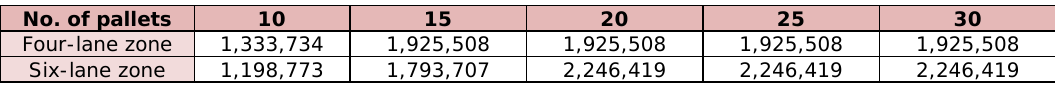
Table 5. “Annual throughput against different numbers of pallets”. Source: